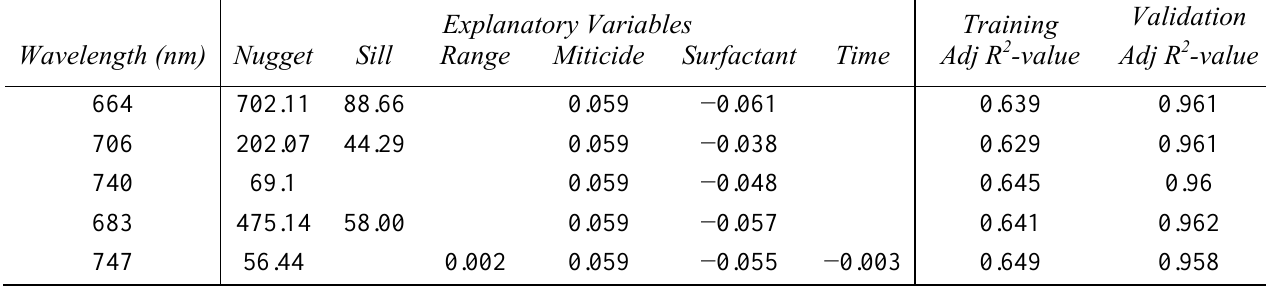
Table 3. Parameters and coefficients from regression fits to miticide bioactivity based on variogram parameters (Nugget, Sill, and Range) and treatment factors (miticide, surfactant, and